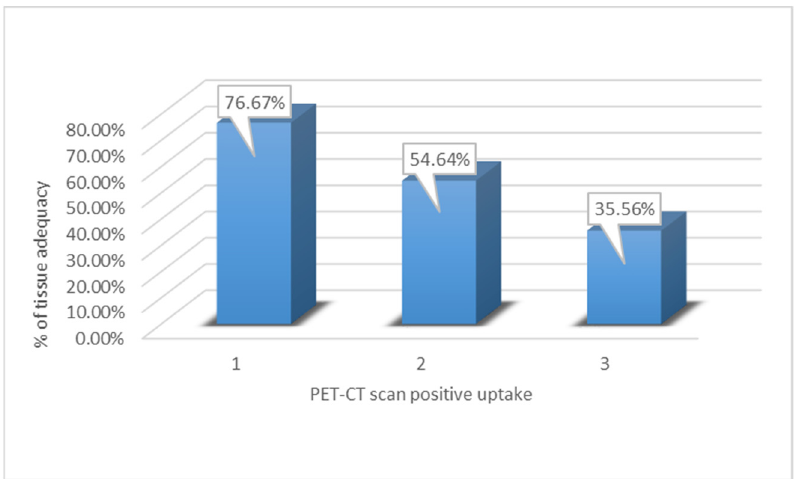
Figure 2. Tissue Adequacy by PET-CT scan: the percentage of tissue adequacy is shown on the y-axis and the PET-CT scan positive FDG uptake levels of 1, 2, and 3 are shown on the X axis.